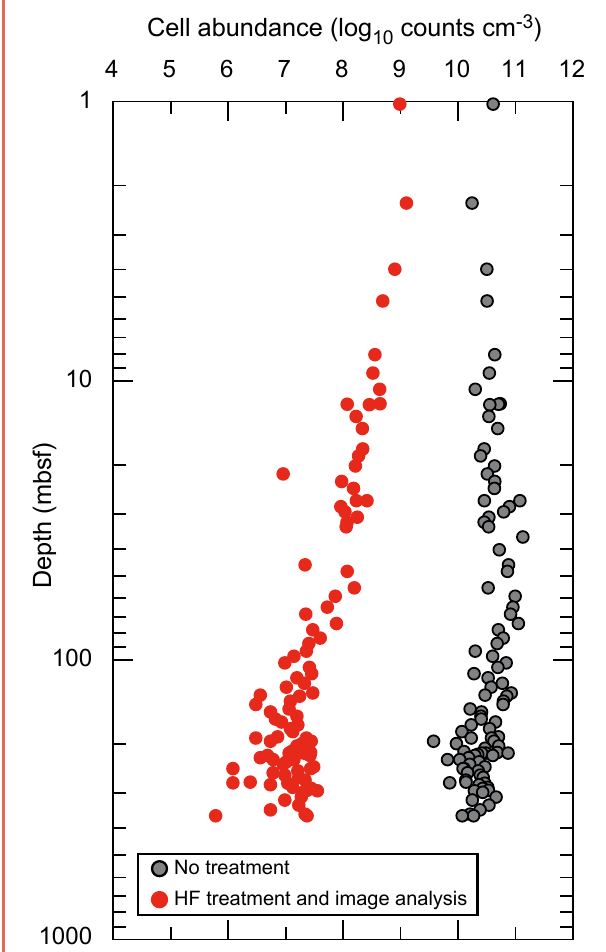
Figure 4. SYBR-I counts of fluorescence signals in sediments collected from offshore of the Shimokita Peninsula of Japan during the D/V Chikyu shakedown expedition CK06-06. Gray dots: no acid wash and manual (human-eye) cell counting results without image analysis (seriously overestimated). Red dots: computer-based cell counts in HF-washed sediment samples (modified from Morono et al., 2009).